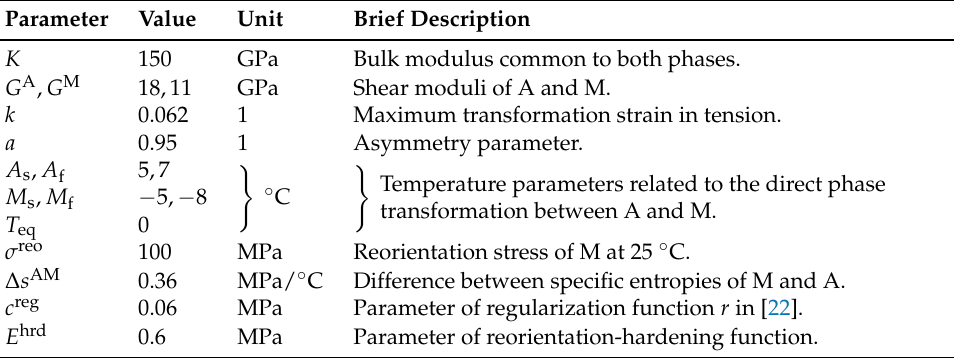
Table 1. Table of material parameters with their brief descriptions. A and M denote austenite and martensite,